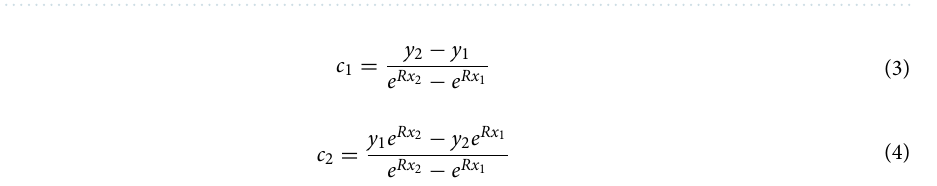
Figure 2. Schematic of the ( a ) perspective view and ( b ) planar top view (in the x–y plane) of the tapered antenna